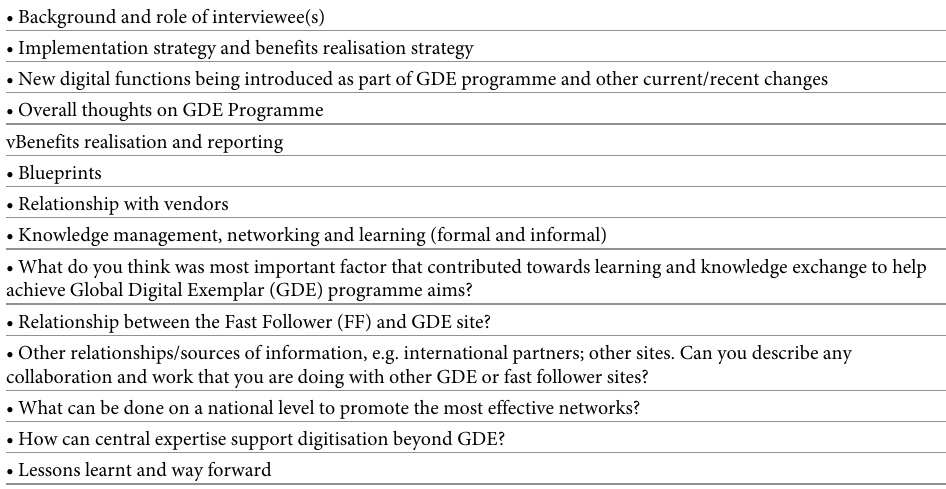
Table 1. High-level interview topic guide focusing on exploring the Global Digital Exemplar/Fast follower